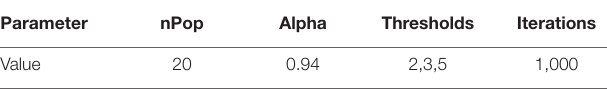
TABLE 1 | Experimental parameter setting.